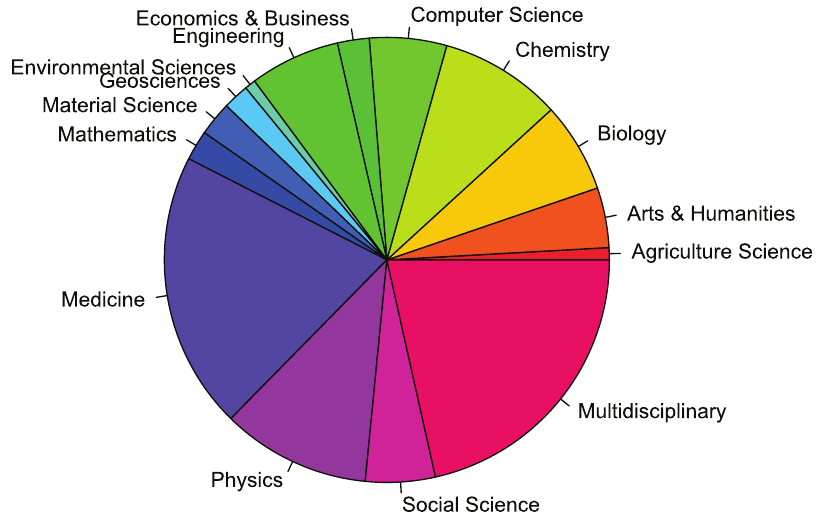
Figure 3. The relative number of documents on the web for each of the 15 fields as defined by MAS.